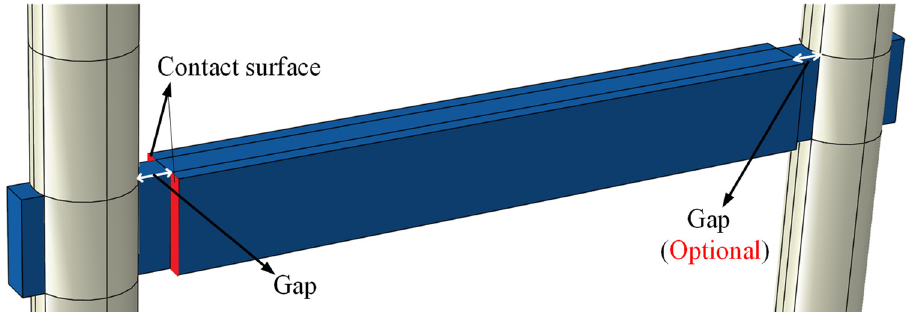
Figure 15. Gap between the mortise and tenon.